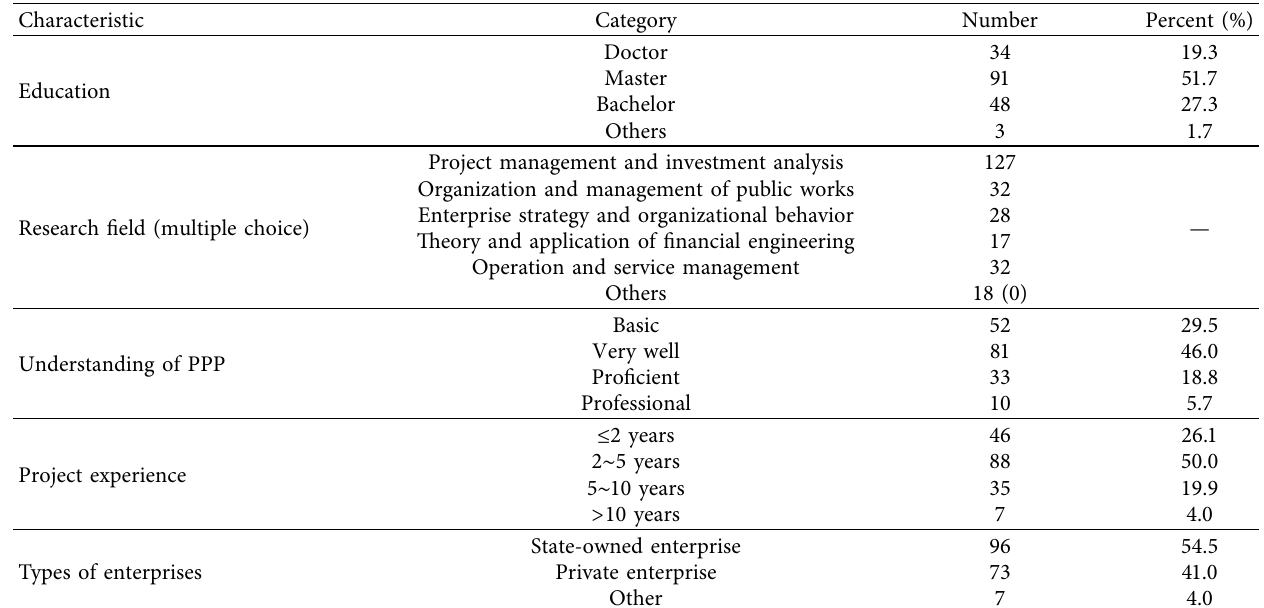
Table 1: The background of the